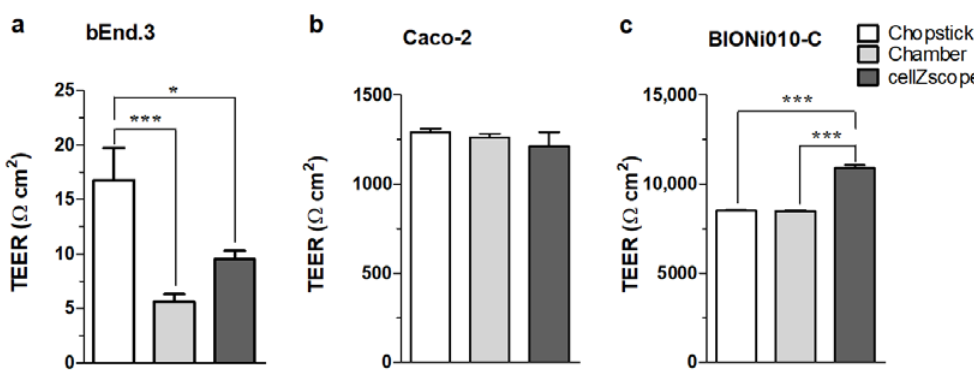
Figure 5. Transcellular (endothelial or epithelial) electrical resistivity (TEER) measurements on barrier models expressing different tightness: ( a ) bEnd.3 cells represent a model with low barrier tightness, ( b ) the Caco-2 intestinal cell line serves as a tight epithelial monolayer, and ( c ) the Bioni010-C derived human endothelial cells express exceptionally tight barrier properties. Data are shown as means ± SEM of one individual passage with 12 individual permeable supports ( n = 1, total N = 12) for Caco-2 and Bioni010-C derived endothelial cells, and one individual passage with 24 individual permeable supports ( n = 1, total N = 24) for bEnd-3 cells. Statistical analysis one-way ANOVA analysis and Tukey’s multiple comparison test; * p < 0.05, *** p < 0.001.